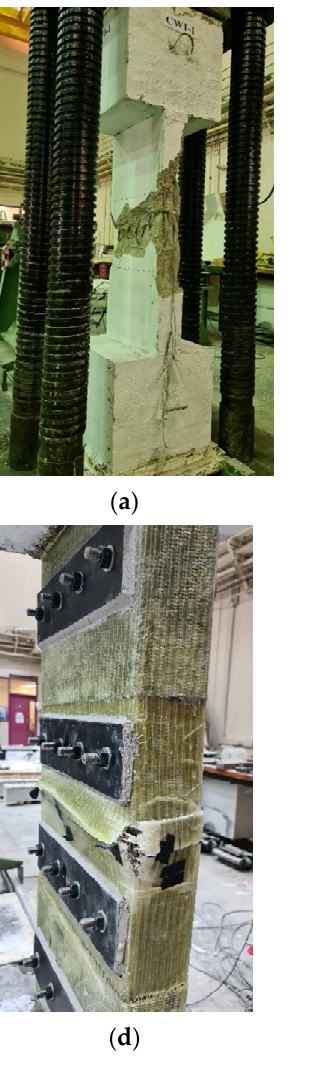
Figure 10. Observed failure modes of columns: ( a ) C1; ( b ) C2; ( c ) S1; ( d ) S2; ( e ) S3; ( f ) S4.